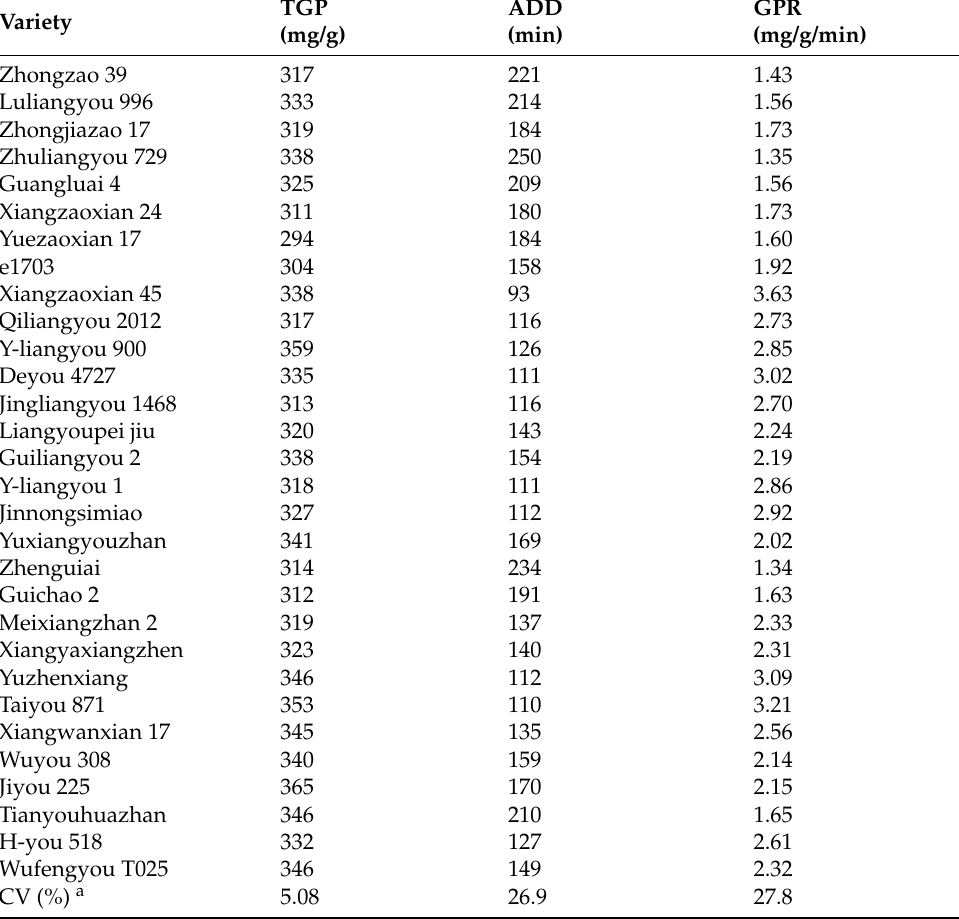
Table 2. Starch digestion properties (GPR, glucose production rate; ADD, active digestion duration; and TGP, total glucose production) of cooked rice of 30 rice